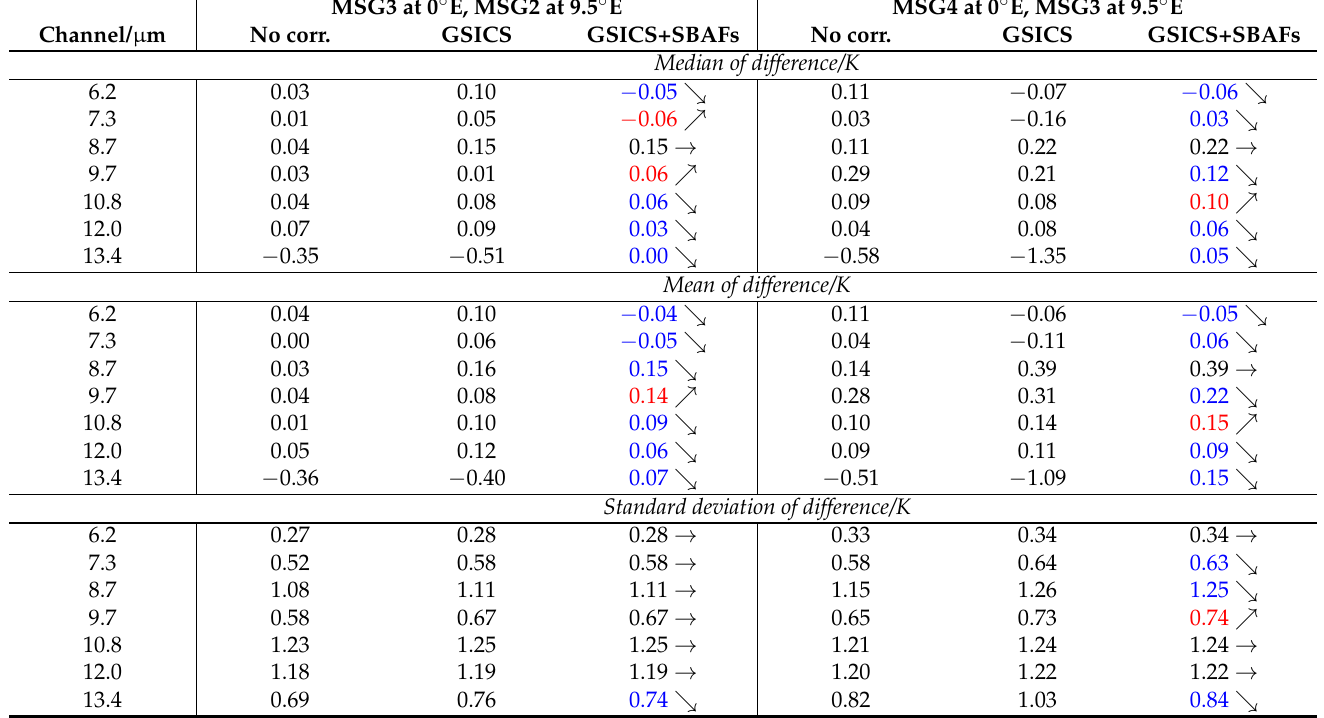
Table 3. Differences in the equivalent brightness temperatures between collocated and simultaneous observations of operational and rapid scan MSG/SEVIRI units. Columns 2–4 show the results for MSG3 at 0 ◦ E (operational) and MSG2 at 9.5 ◦ E (rapid scan mode) with 33,192 samples. Columns 5–7 show the results for MSG4 at 0 ◦ E (operational) and MSG3 at 9.5 ◦ E (rapid scan) with 33,216 samples. The median, mean, and standard deviation in the difference of equivalent brightness temperatures are given with no corrections applied ( No corr. ), with re-analysis GSICS-corrections applied to both imagers ( GSICS ), and with re-analysis GSICS-corrections applied to both imagers and additionally SBAFs to map the operational imager to the rapid scan unit ( GSICS+SBAFs ). In the latter case, font color and a marker indicate whether the absolute error metrics for GSICS+SBAFs are lower (blue, (cid:38) ), same (black, → ) or larger (red, (cid:37) ) than the results for GSICS